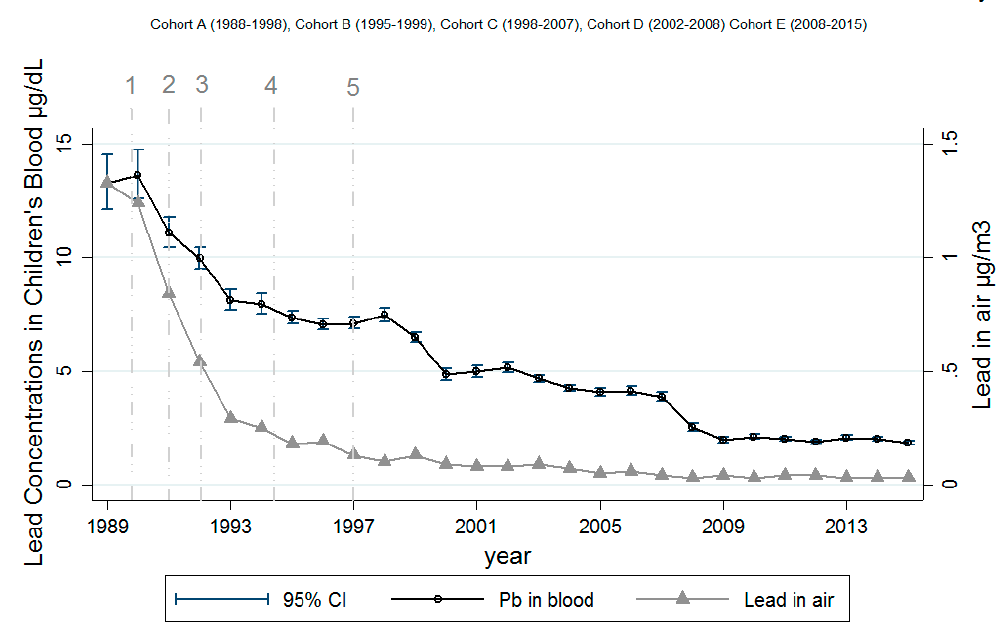
Figure 3. Results of adjusted mixed models for blood lead concentrations and air lead concentrations over the years. 1 = 1990: Introduction of “Magna Sin” (reduced lead) gasoline and one day a week without driving your car program. 2 = 1991: Closure of oil refinery in Mexico City (Azcapotzalco). Reduction to 0.5–1 mL/gal of tetraethyl lead in gasoline. 3 = 1992: Reduction to 0.2–0.3 mL/gal of tetraethyl lead in gasoline. 4 = 1994: Reduction to 0.1–0.2 mL/gal of tetraethyl lead in gasoline. 5 =